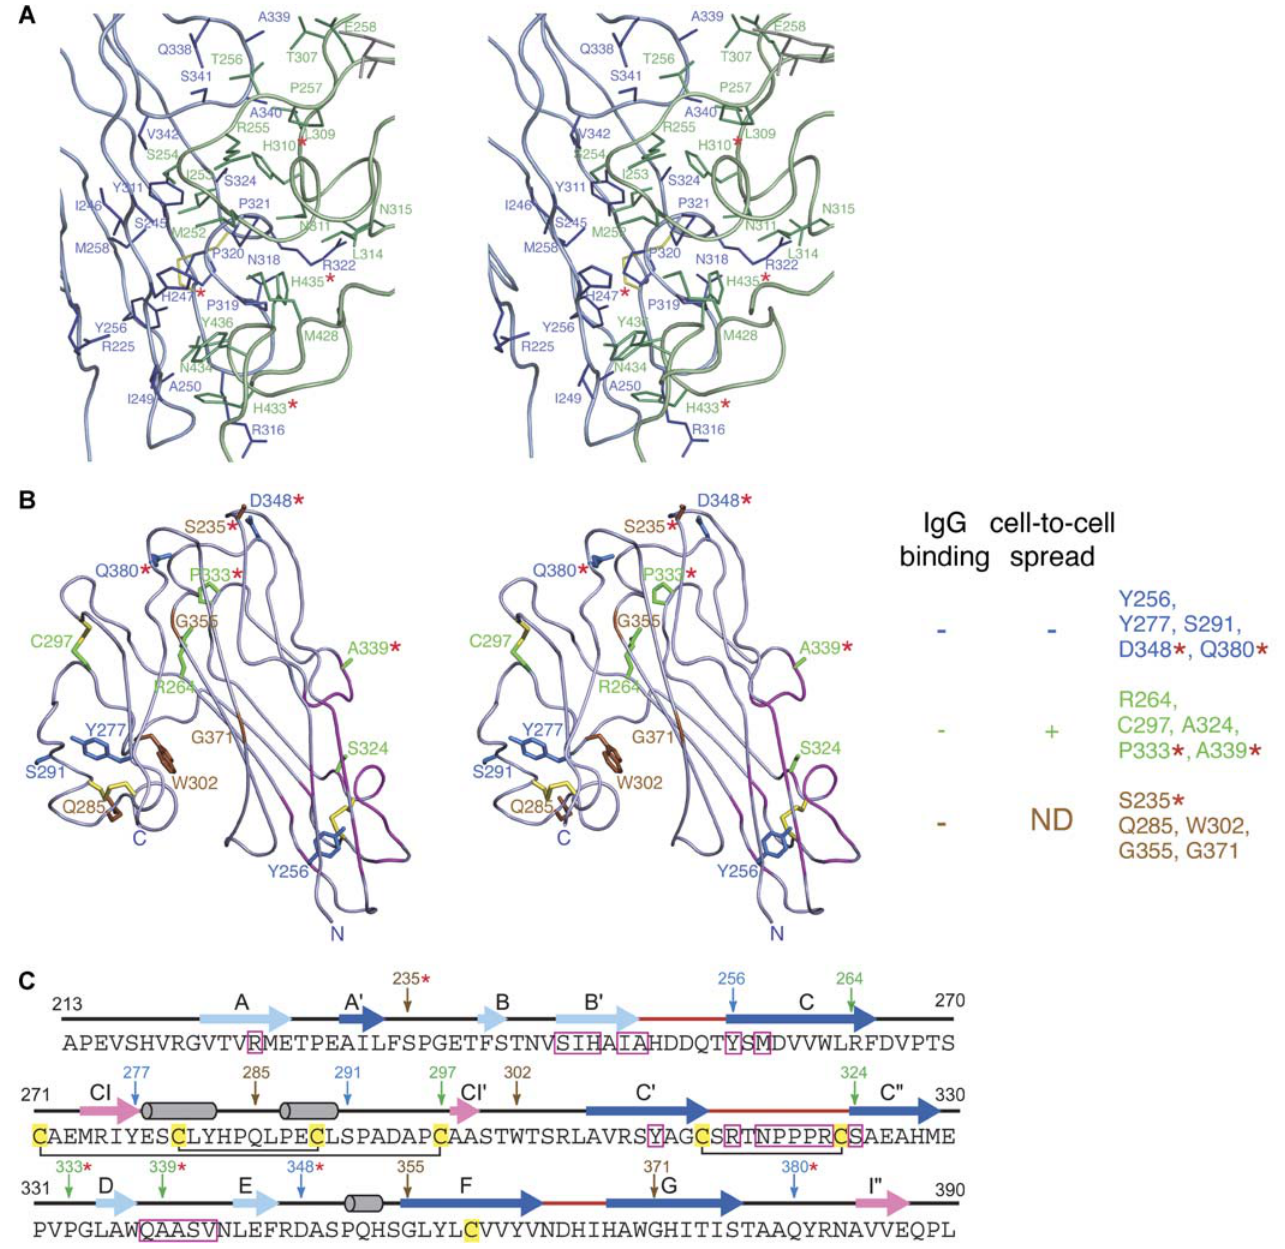
Figure 4. Interfaces of CgE Involved in IgG Binding and Cell-to-Cell Spread (A) A close-up of predicted side-chain interactions in the CgE/Fc interface. CgE side chains and peptide backbone are blue, Fc side chains and peptide backbone are green, and disulfide bonds are yellow. Regions above and below the plane of the interaction have been omitted for clarity. Residues are defined as interacting if one or more side-chain atoms from a residue in one protein are within 5 A˚ of a side-chain atom on the partner protein, which includes residues 225, 245–247, 249–250, 256, 258, 311, 316, 318–322, 324, and 338–342 on CgE and 252–258, 307, 309–311, 314–315, 382, 428, and 433–436 on Fc. Histidine residues in the interface are indicated with red asterisks. Fc residue 382 is not visible in this orientation of the interface. (B) Insertion mutants in CgE that disrupt Fc binding and/or viral spread mapped onto the CgE structure. The CgE backbone is shown in blue with regions that are predicted to be in the CgE/Fc interface shown in magenta. The side chains shown are colored according to the effect that a four- or five-residue linker inserted after them had on IgG binding and viral spread (blue, disrupt IgG binding and viral spread; green, disrupt IgG binding only; and brown, disrupt IgG binding and not tested for viral spread [7,14,17,18,38,39]). Red asterisks indicate residues in surface-exposed loops. (C) Secondary structure of HSV-1 CgE (residues 213–390) mapped on the amino acid sequence. Elements of secondary structure are shown above the sequence with color-coding as in Figure 2A and 2B, and the three CDR loops (as defined in Ig V domain structures) are red. Cysteine residues are highlighted in yellow, with disulfide bonds indicated by black lines between paired cysteines. The insertion mutagenesis data described in (B) is depicted as colored arrows above the sequence with red asterisks indicating residues in surface-exposed loops. Residues that are in the predicted CgE/ Fc interface based on the crystallographic data are boxed in magenta. DOI: 10.1371/journal.pbio.0040148.g004